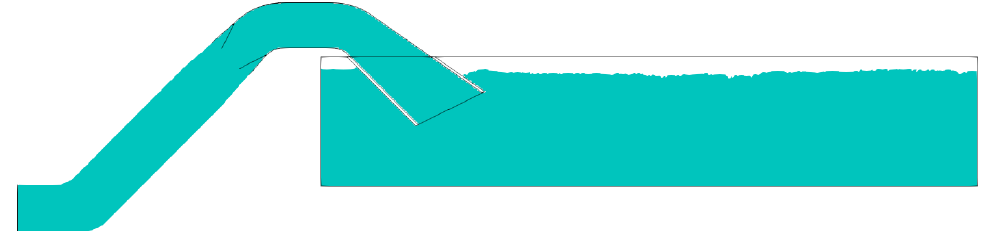
Figure 5. Siphon filled with water when calculating from initial condition (31)–(33). Front part of a cut at z =